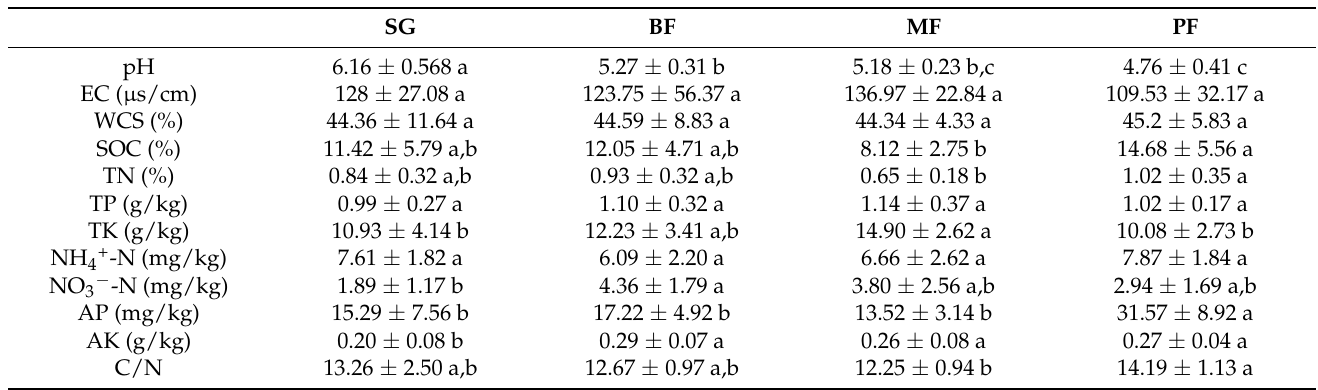
Table 1. Soil properties under different vegetation